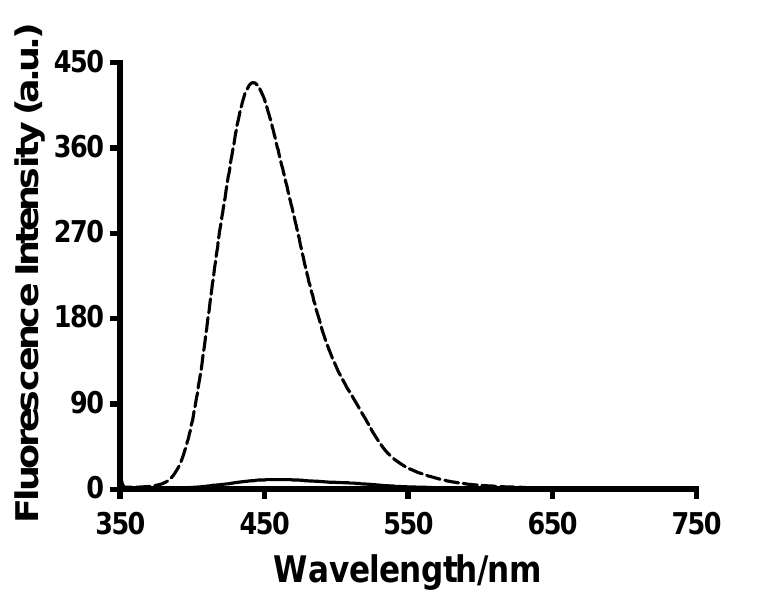
Figure 3 . Fluorescence spectra of 4 × 10 -5 M 2,6-ANS and in the absence (  ) and in presence of 1 mM PAMAM dendrimer G5 (----).